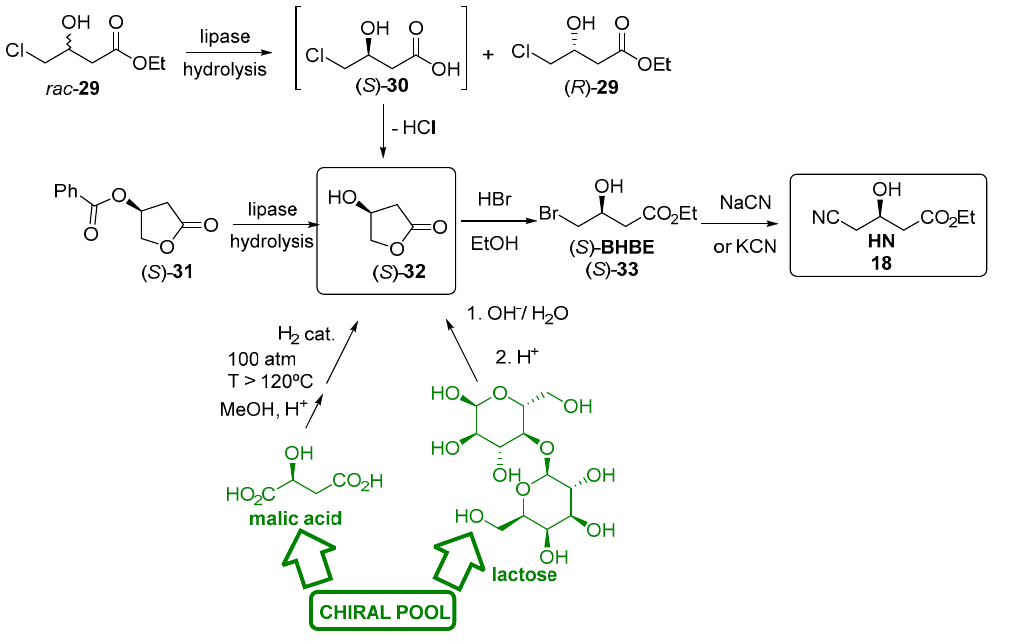
Figure 7. Preparation of HN 18 starting from ( S )-3-hydroxy butyrolactone ( S )- 32 .